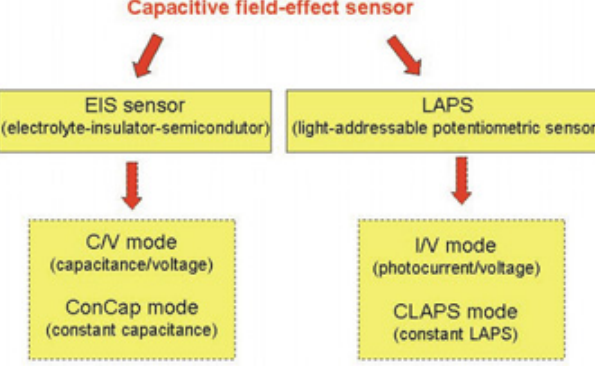
Figure 2. Measuring principles of EIS sensor and LAPS, respectively.